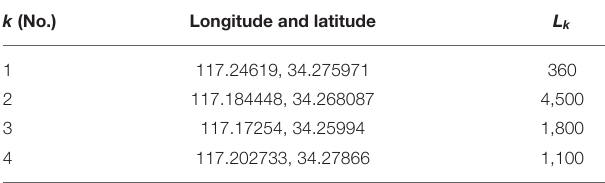
TABLE 3 | Coordinates and capacity of designated higher-level hospital k